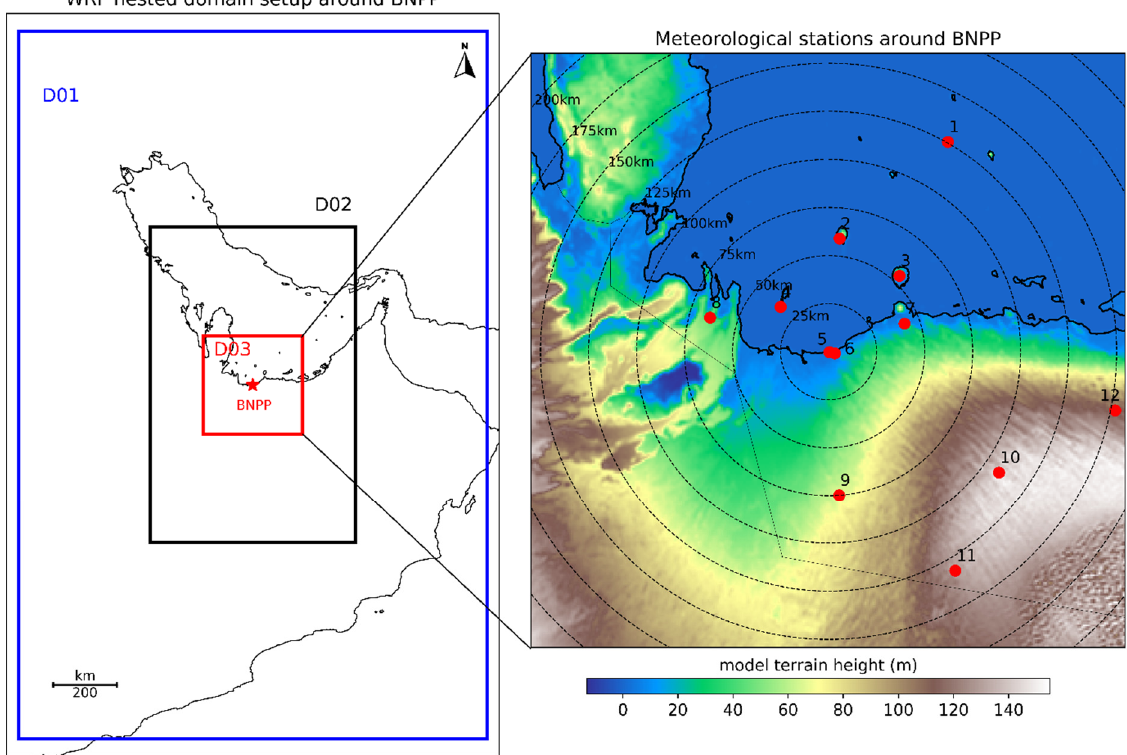
Figure 1. Study area for the experiments. ( Left ) The WRF domain configuration consists of three telescoping nests centered at BNPP. The star symbol depicts the BNPP location. The outermost boundaries denote the parent grid (D01). D02 and D03 are the nested domains. ( Right ). Left panel is a zoom of the innermost domain showing the model terrain height along with the spatial distribution of the 12 surface stations around BNPP. Each station is denoted by a red disk symbol and labeled by a